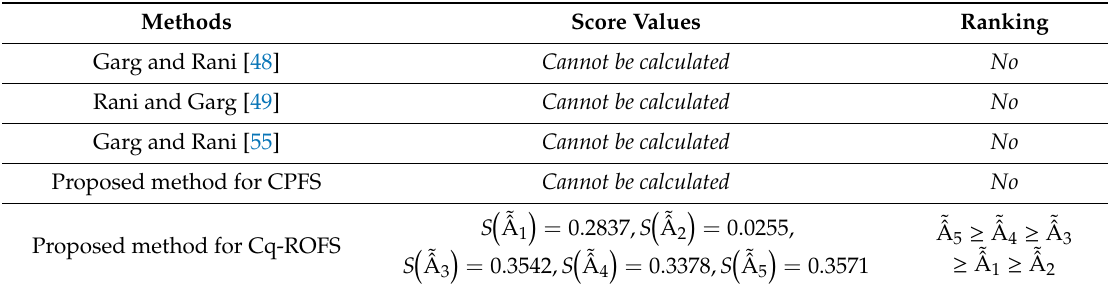
Table 12. Comparative analysis for Example 7.